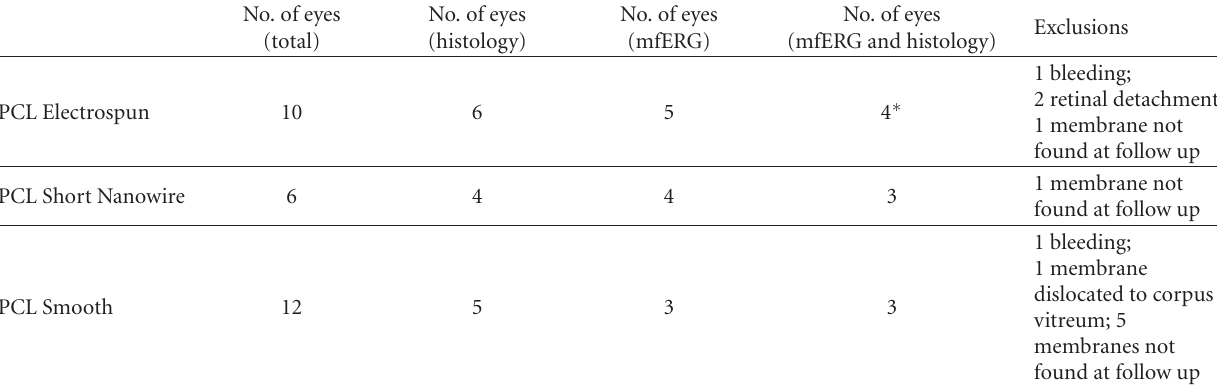
Table 1: Number of implanted, included, and excluded polymer sca ff olds, by type.